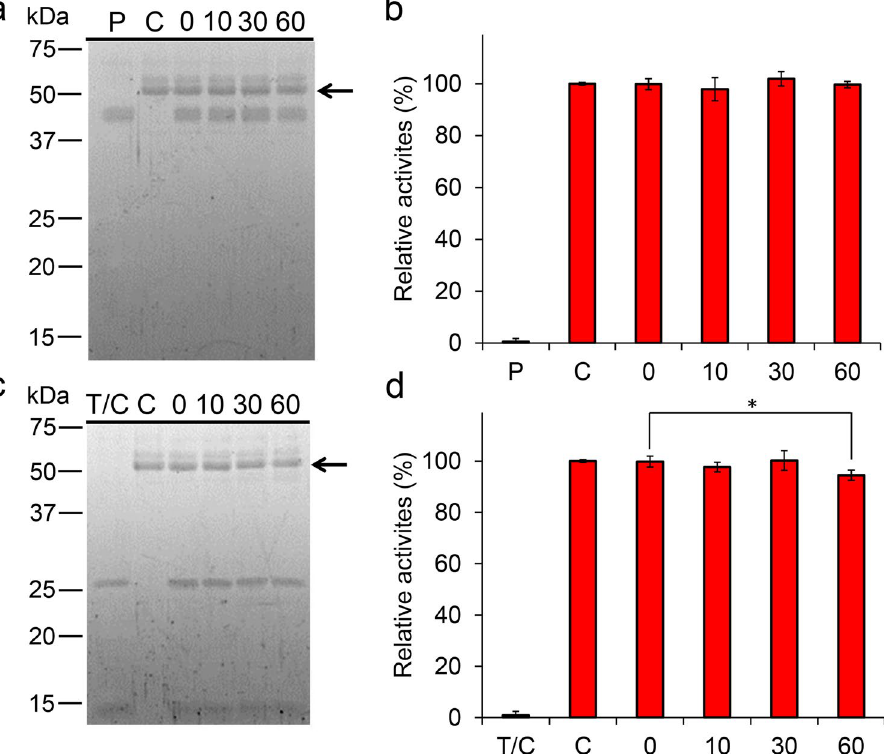
Figure 3. Functional stability of chicken Chia against gastrointestinal proteases. Purified Chia was incubated at 37 °C for 0, 10, 30, and 60 min under stomach-like ( a , b ) or intestine-like ( c , d ) environment in the presence of pepsin or trypsin and chymotrypsin at equal mass concentration of Chia. The samples were analyzed by SDS- PAGE and following ( a , c ) SYPRO Ruby staining, ( b , d ) chitinolytic activities. C, purified enzyme only; P, pepsin only; T/C, trypsin and chymotrypsin only; numbers, incubation time. Values in ( b , d ) represent mean ± SD conducted in triplicate. * p < 0 . 05 . P-values were determined using Student’s